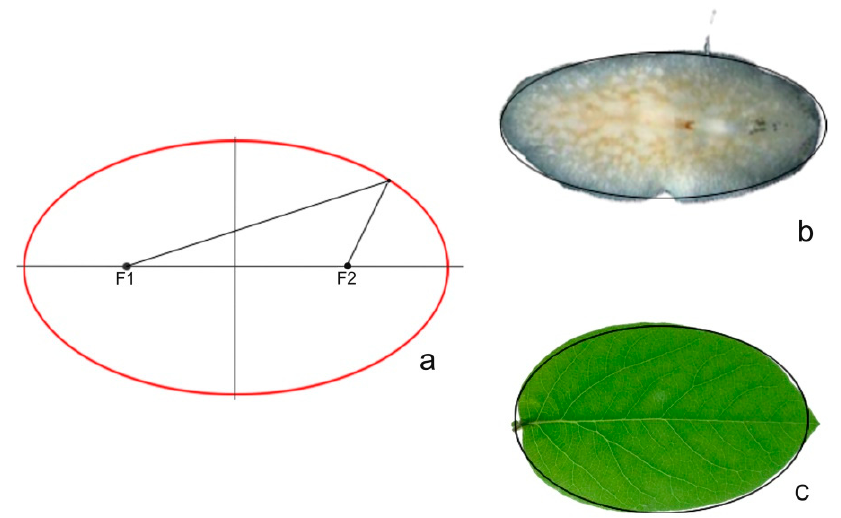
Figure 3. ( a ) The ellipse is a regular oval curve, traced by a point moving in a plane so that the sum of its distances from two other points (the foci, F1 and F2) is constant. The ellipse is observed in the image of a platelmynth ( b ) and in leaves of many species ( c ).